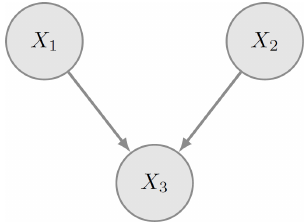
Figure 3. Illustrative Bayesian network with three